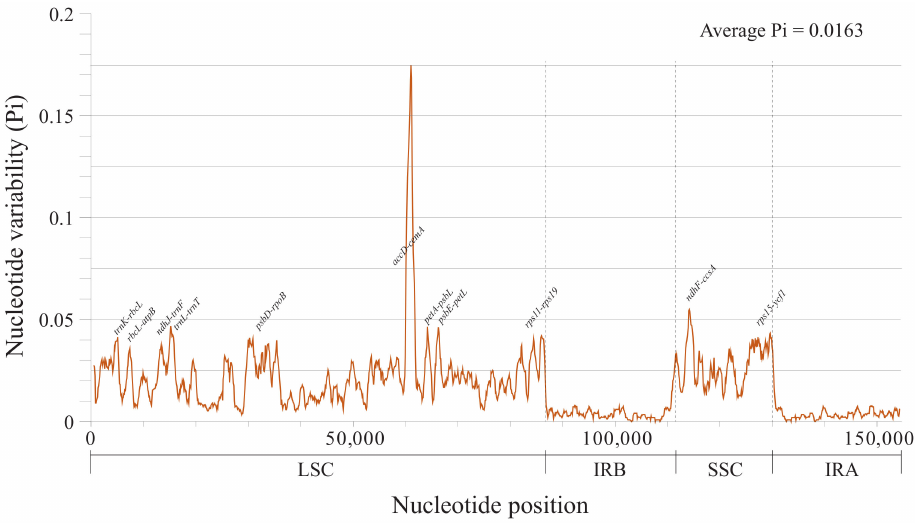
Figure 6. Nucleotide variability (Pi) values among chloroplast genomes of six Desmodieae